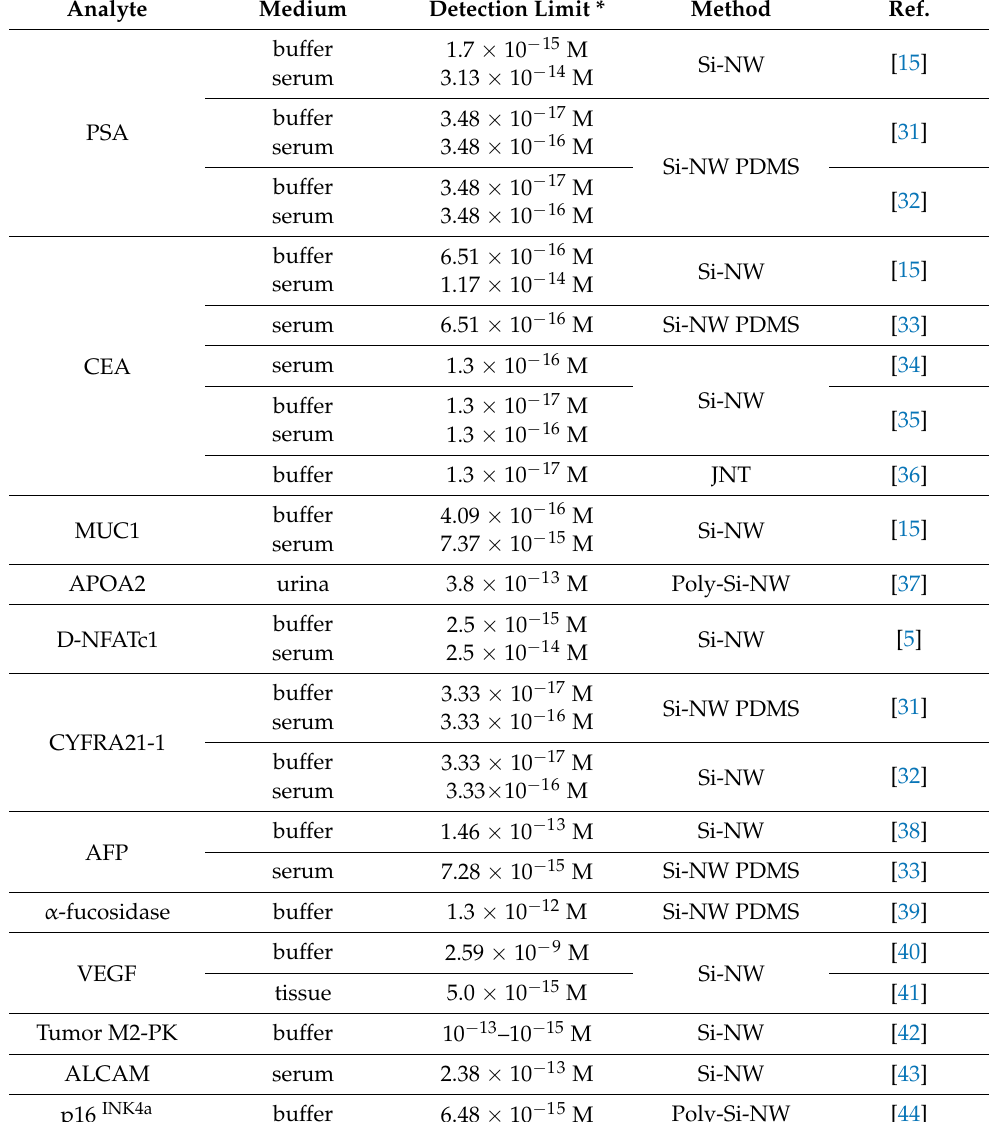
Table 1. Detection of proteins associated with various types of oncopathology, using nanowire silicon